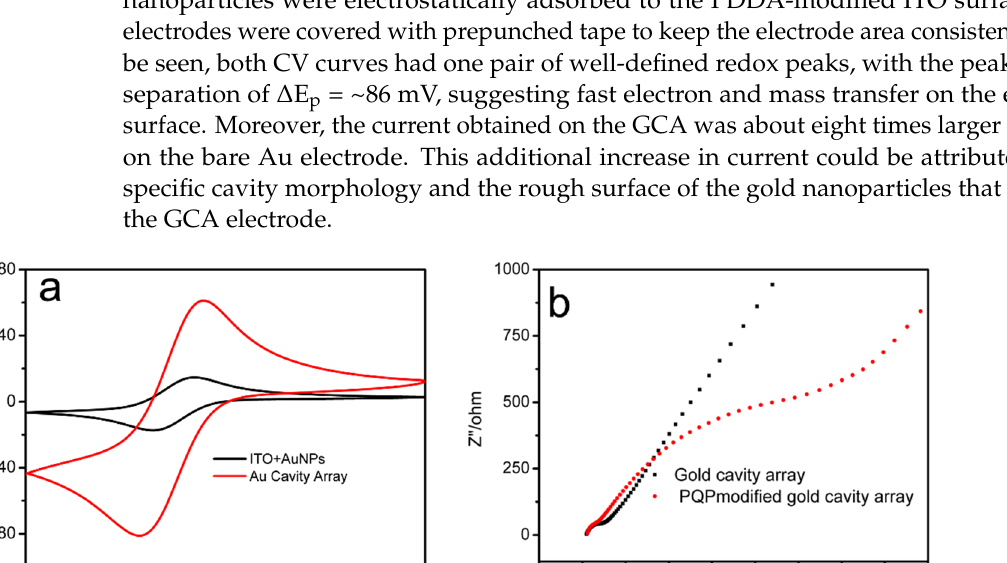
Figure 4. CV curves of the GCA electrode, PQT@GCA, and AuNPs@ITO electrode in 0.2 mol/L NaClO 4 with and without H 2 O 2 . The sulfhydryl groups in the PQT molecules formed Au ‐ S bonds and were firmly immobilized on the GCA surface. The coverage of the electroactive substance on the GCA electrode could be calculated according to the Laviron Equation (1) [43].